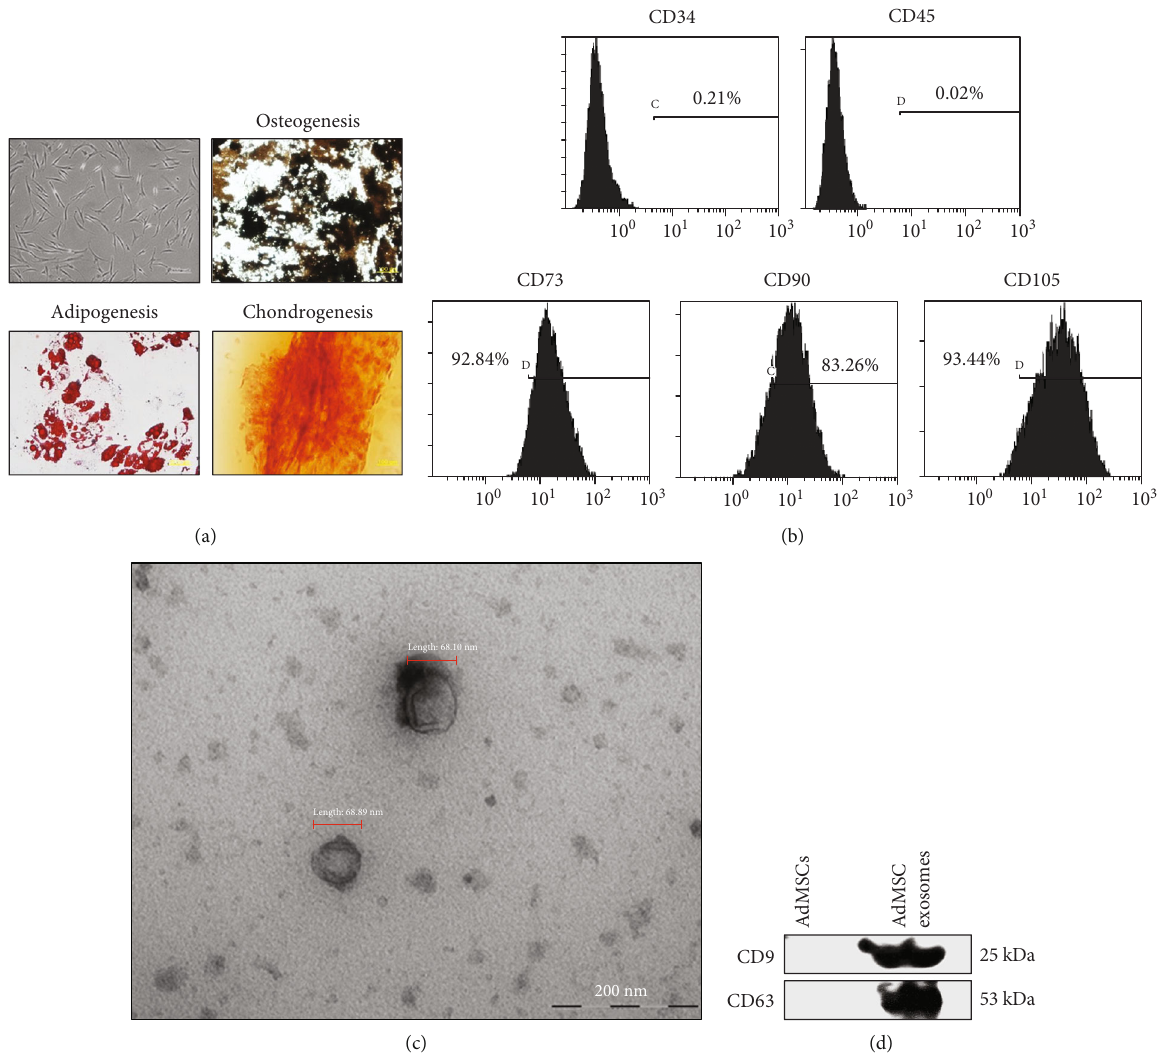
Figure 3: Isolation and characterization of AdMSCs and AdMSC-derived exosomes. (a) Morphology of cultured AdMSCs displayed the typical spindle shape of MSCs (magni fi cation, 100x). Under speci fi c di ff erentiation conditions, AdMSCs were di ff erentiated into osteoblasts (magni fi cation, 200x), adipocytes (magni fi cation, 400x), and chondrocytes (magni fi cation, 200x). (b) Flow cytometry histograms show the positive or negative immunophenotype of cultured AdMSCs. The cells expressed CD73, CD90, and CD105, known as MSC markers. (c) Morphology of exosomes was identi fi ed by transmission electron micrograph (TEM). Scale bar = 200nm . (d) Protein expression of CD9 and CD63, the exosomes markers, was analyzed by western blot